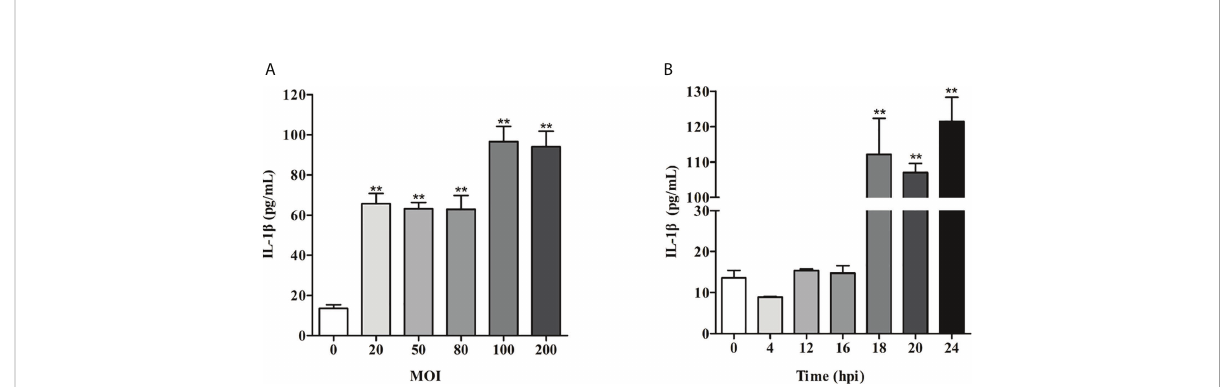
FIGURE 1 IL-1 b induction of IPEC-J2 cells by ETEC infection is MOI- and time-dependent. (A) IL-1 b secretion induced by ETEC infection at different MOI. (B) Time course of IL-1 b secretion post-ETEC infection. The x-axis indicates hours post infection. Data are presented as mean ± SEM from 3 independent experiments. **P < 0.01 compared to 0 MOI (A) or 0 hpi (B)